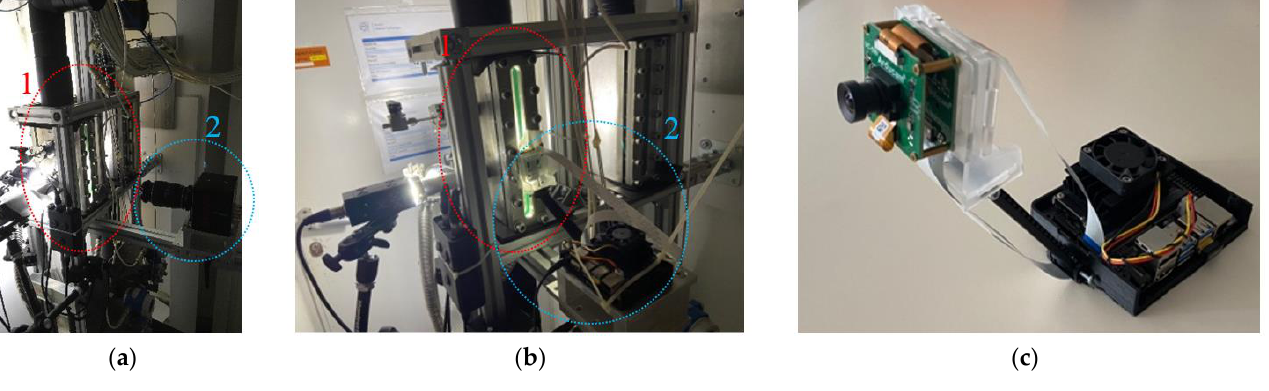
Figure 2. The experimental setup: ( a ) the FastCam (2) deployed to collect data from the observation section of the test rig (1) for training and offline testing; ( b ) The prototype (2) deployed to capture and process live video footage from the observation section of the test rig (1); ( c ) the prototype.